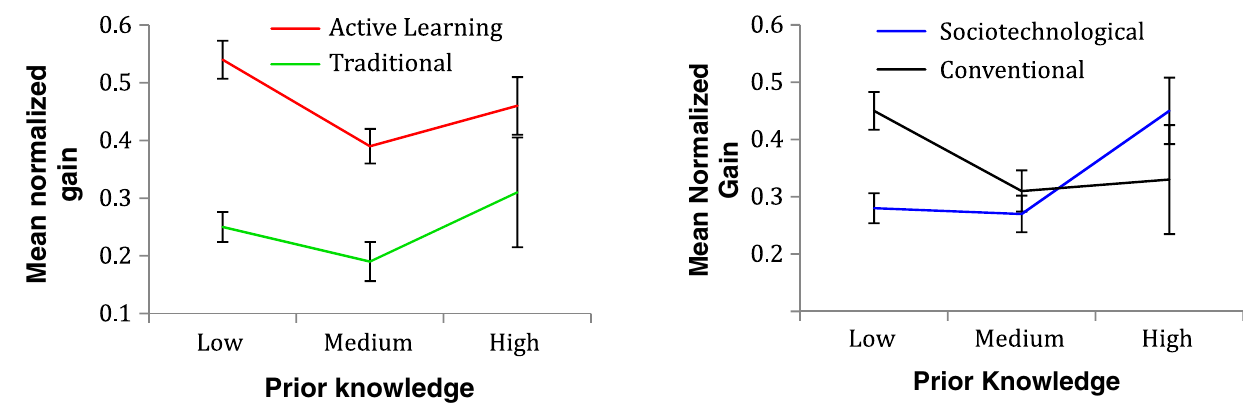
FIG. 5. Differences in normalized gain for students with low, medium, and high prior knowledge in either sociotechnological or conventional classrooms. Error bars represent the standard error to the mean.